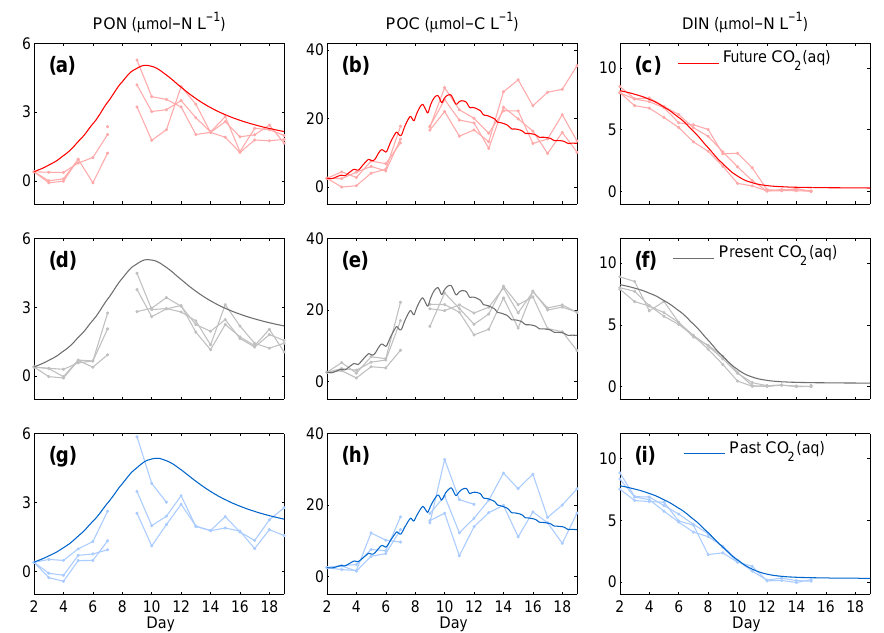
Figure 2. Solid lines show reference runs for POC, PON, and DIN simulating the mean of the replicates per treatment level, with different colors for the three experimental CO 2 setups. Dots are replicated data from the Pelagic Enrichment CO 2 Experiment (PeECE II) for newly produced POC and PON, i.e., starting values at day 2 were subtracted from subsequent measurements as in Riebesell et al.